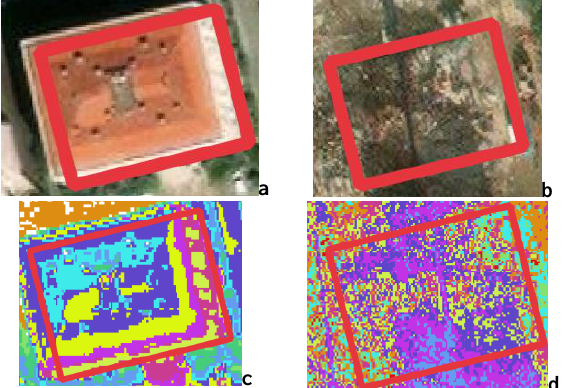
Figure 9. a-A sample building (pre-EQ), b- Collapsed (post EQ), c-Cluster from pre-EQ, d- c-Clusters from post-EQ).